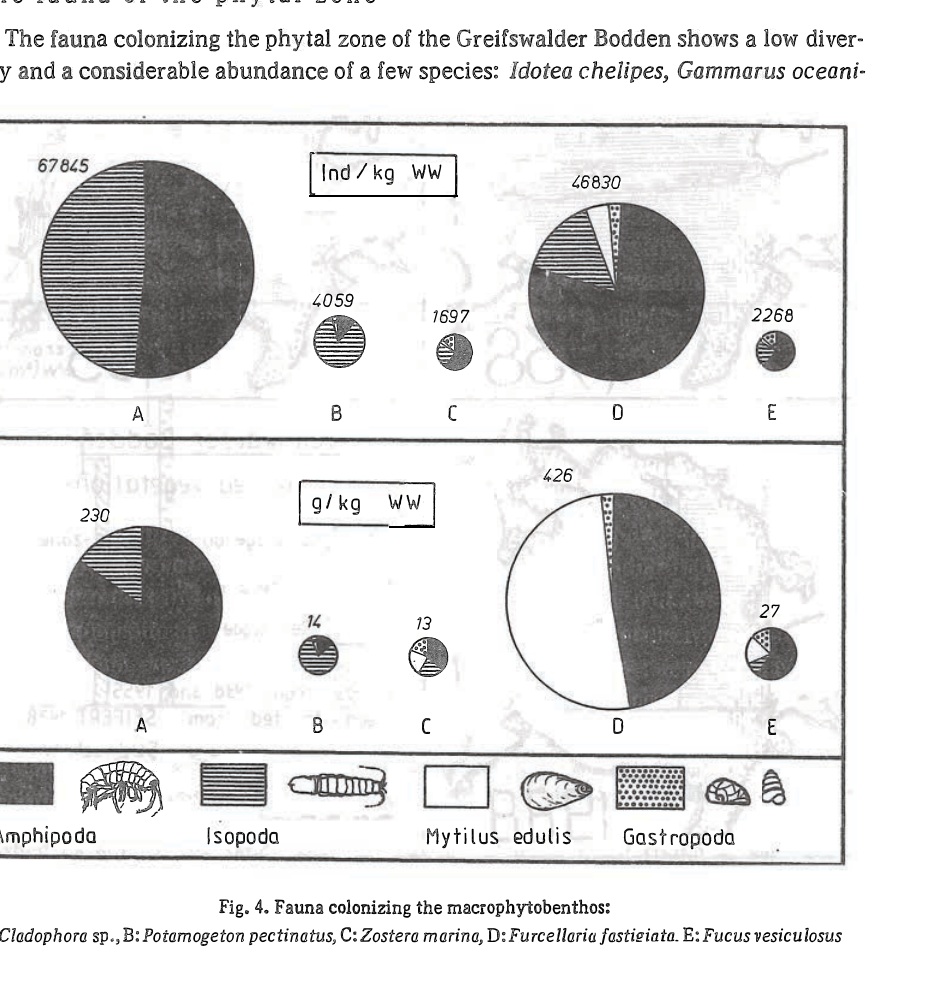
Fig. 4. Fauna colonizing the